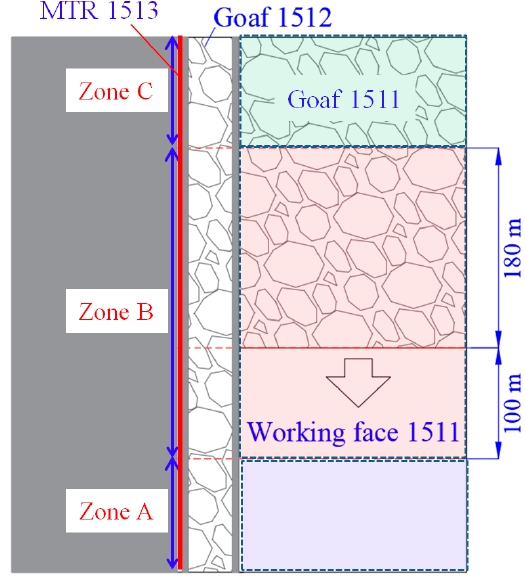
Figure 5. Result of zone division on MTR 1513.